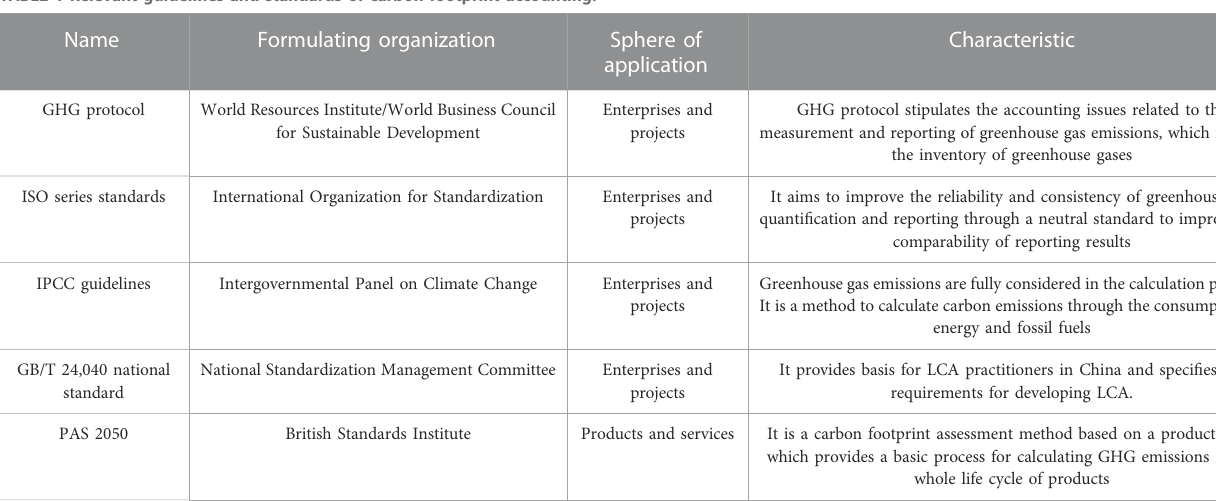
TABLE 1 Relevant guidelines and standards of carbon footprint accounting.